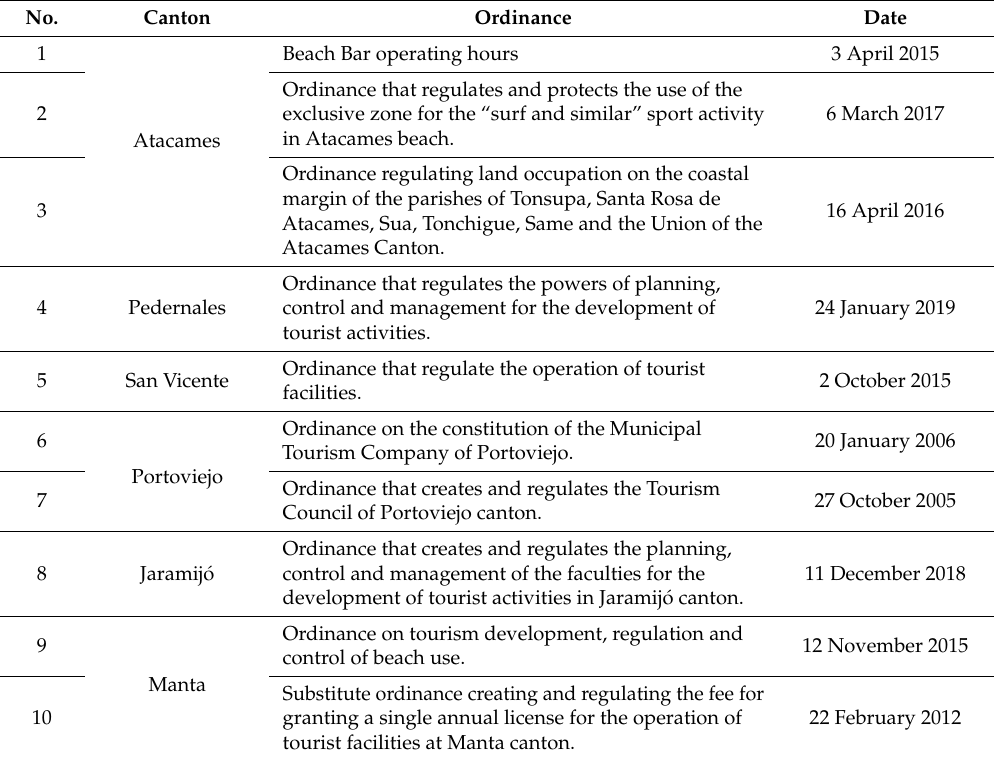
Table 6. List of ordinances that regulate 3S